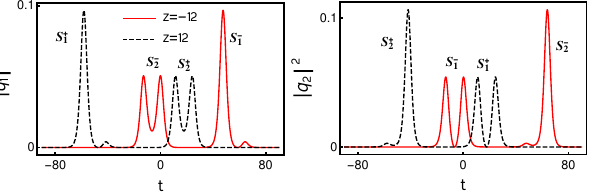
Figure 3. Shape preserving collision between a symmetric double-hump soliton and an asymmetric double-hump soliton: the parameter values are k 1 = 0.333 + 0.5 i , l 1 = 0.315 + 0.5 i , k 2 = 0.315 − 2.2 i , ( 1 ) = 0.45 + 0.45 i , α ( 1 ) = 2.49 + 2.45 i , α ( 2 ) = 0.49 + 0.45 i and α ( 2 ) = 0.45 + 0.45 i l 2 = 0.333 − 2.2 i , α 2 2 1 1